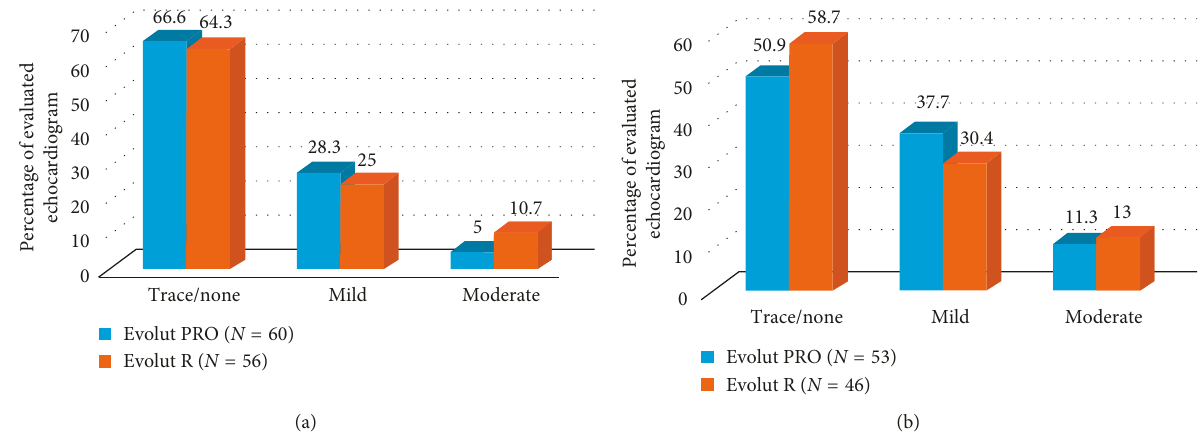
Figure 1: Paravalvular leak at discharge and 30days. Legend: Echocardiographic findings of paravalvular leak (PVL) at discharge (a) and 30days (b) for patients implanted with CoreValve Evolut PRO or CoreValve Evolut R. There is no significant difference between the two